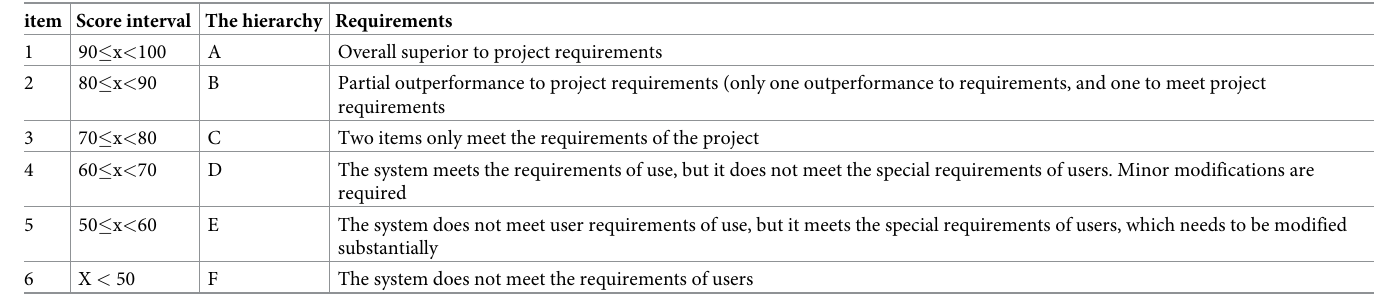
Table 5. Description of the expert grading scale, x is the score given by